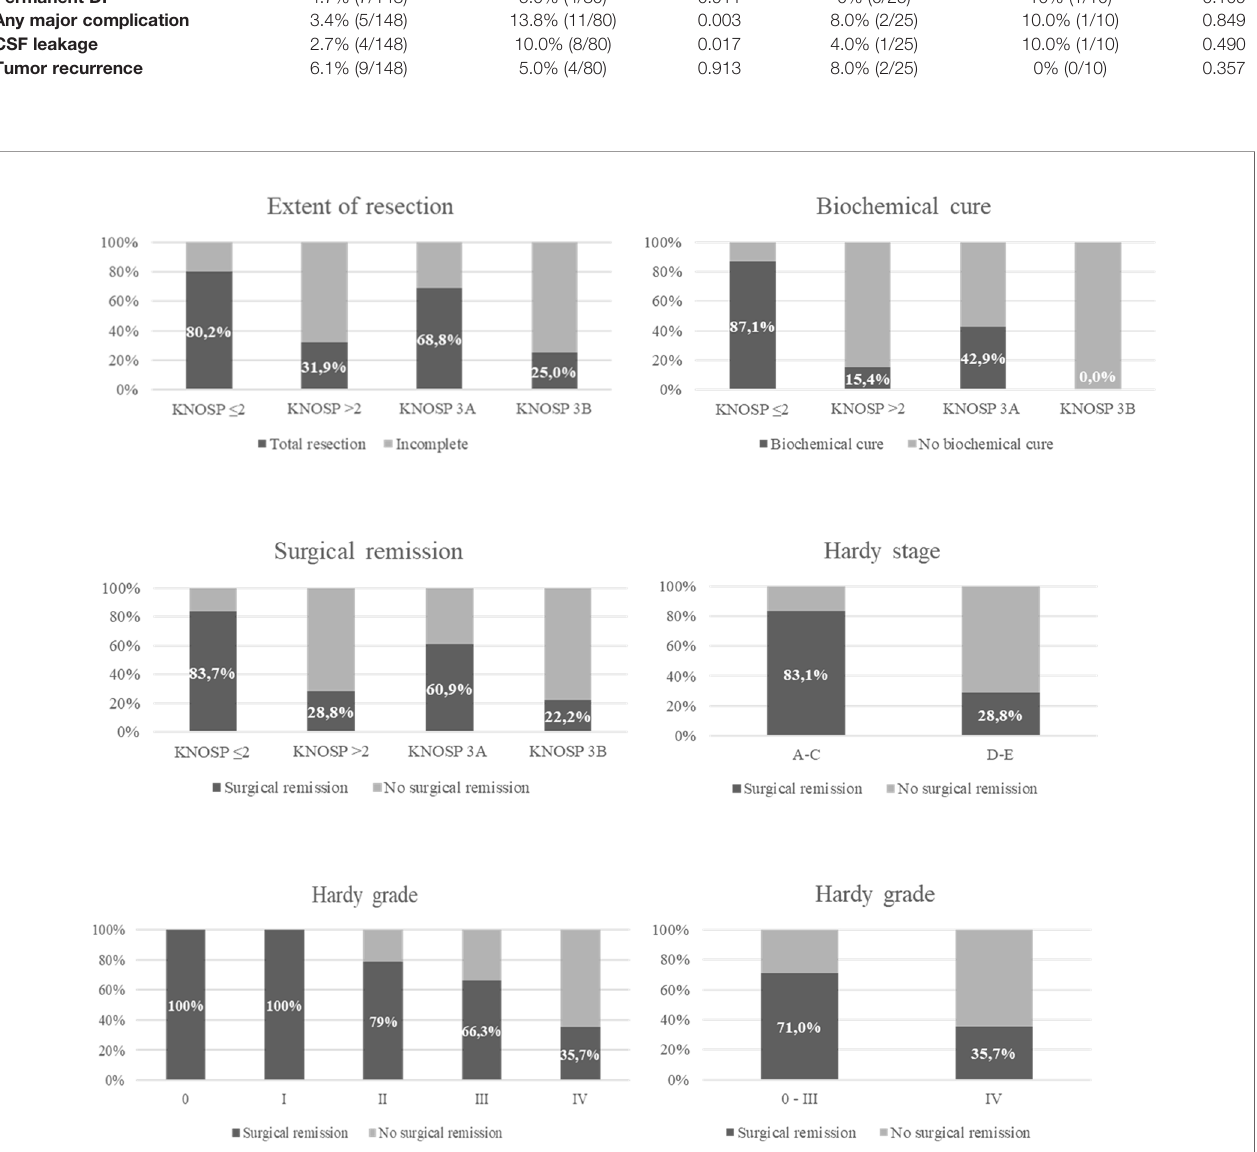
FIGURE 4 | Surgical remission in functioning pituitary adenomas and total resection in non-functioning pituitary adenomas based on Knosp and Hardy classi fi